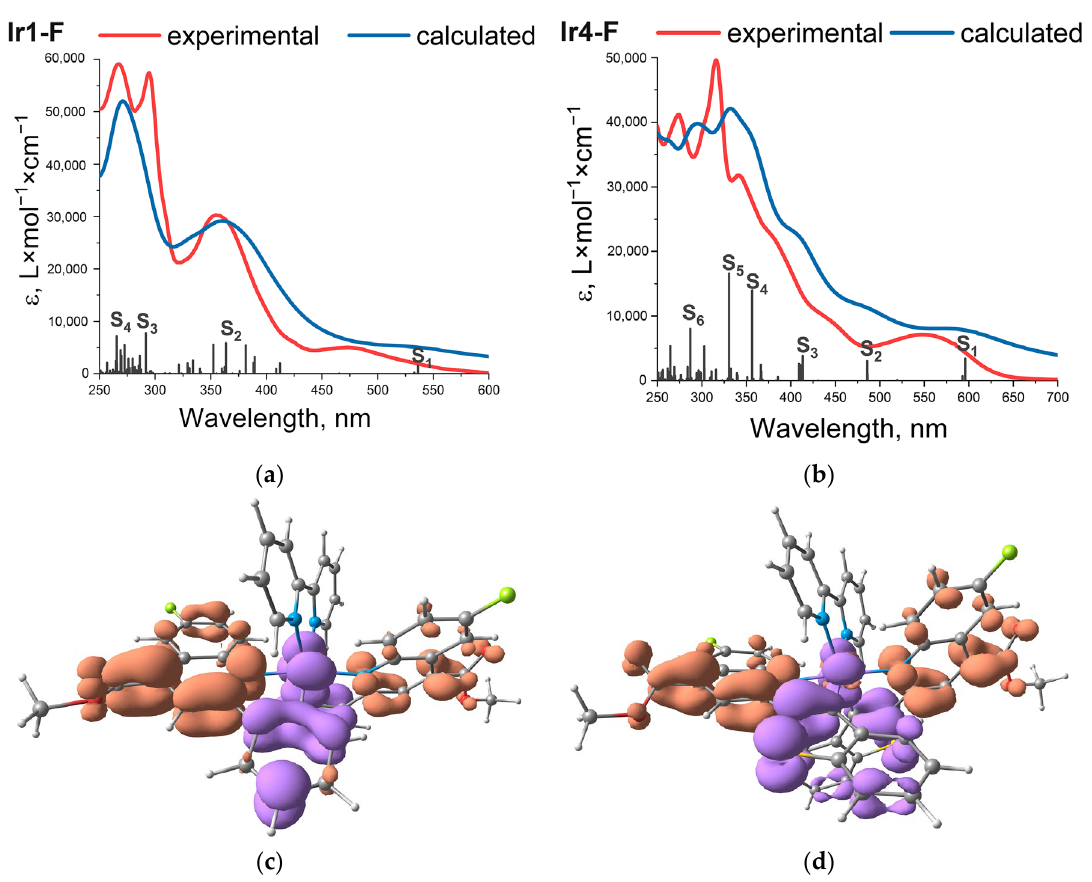
Figure 2. Experimental (red) and calculated (blue) absorption spectra of Ir1-F ( a ) and Ir4-F ( b ); oscillator strengths of electronic transitions are shown with vertical bars along wavelength axis. NTOs of the Ir1-F ( c ) and Ir4-F ( d ) lowest energy (S 0 → S 1 ) transitions: decrease and increase in electron density are given in violet and terracotta colors, respectively.